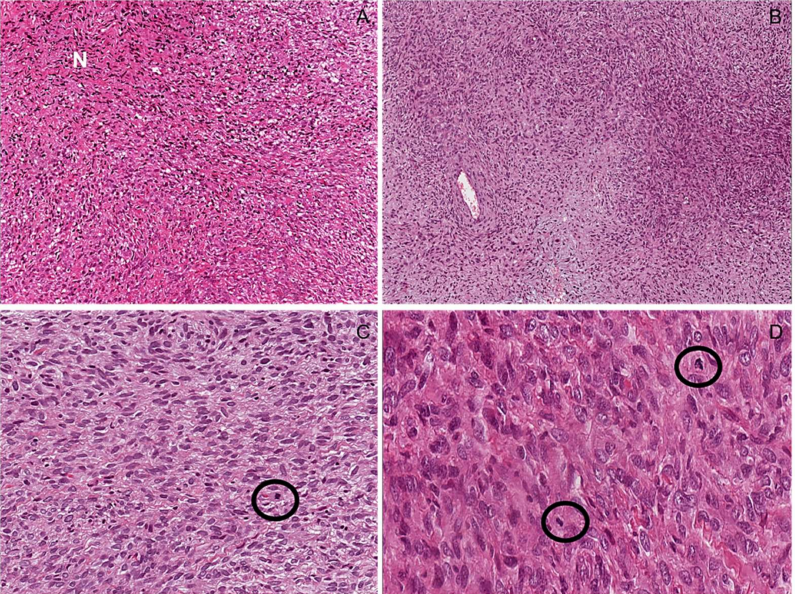
Figure 9. Atypical neurofibromatous tumor with uncertain biological behavior. ( A ) Low-magnification image showing hypercellular tumor with focal area reminiscent of neurofibroma (N). ( B ) Tumor area with alternating hypercellular and hypocellular areas. ( C , D ) Mitoses (circles) and moderate nuclear atypia are seen ( D ); tumor necrosis was absent. Table 6. Atypical neurofibromatous neoplasm with uncertain biologic potential (ANNUBP).